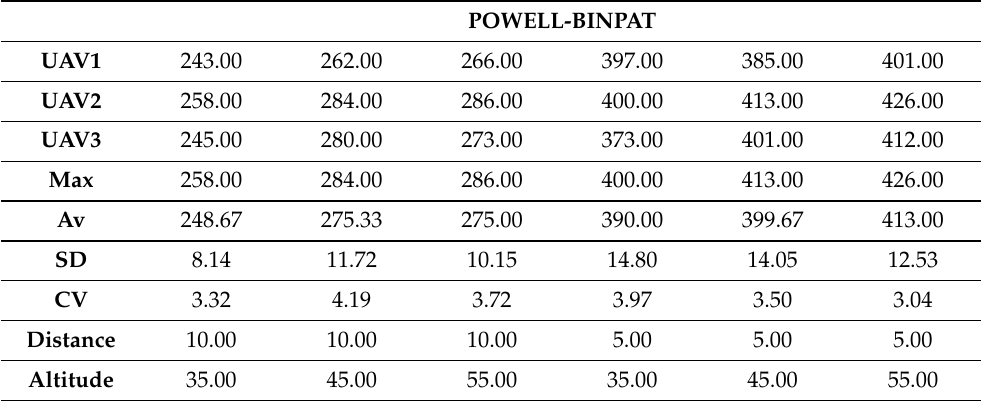
Table A3. Time results using the POWELL-BINPAT algorithm and three UAVs in a short- track